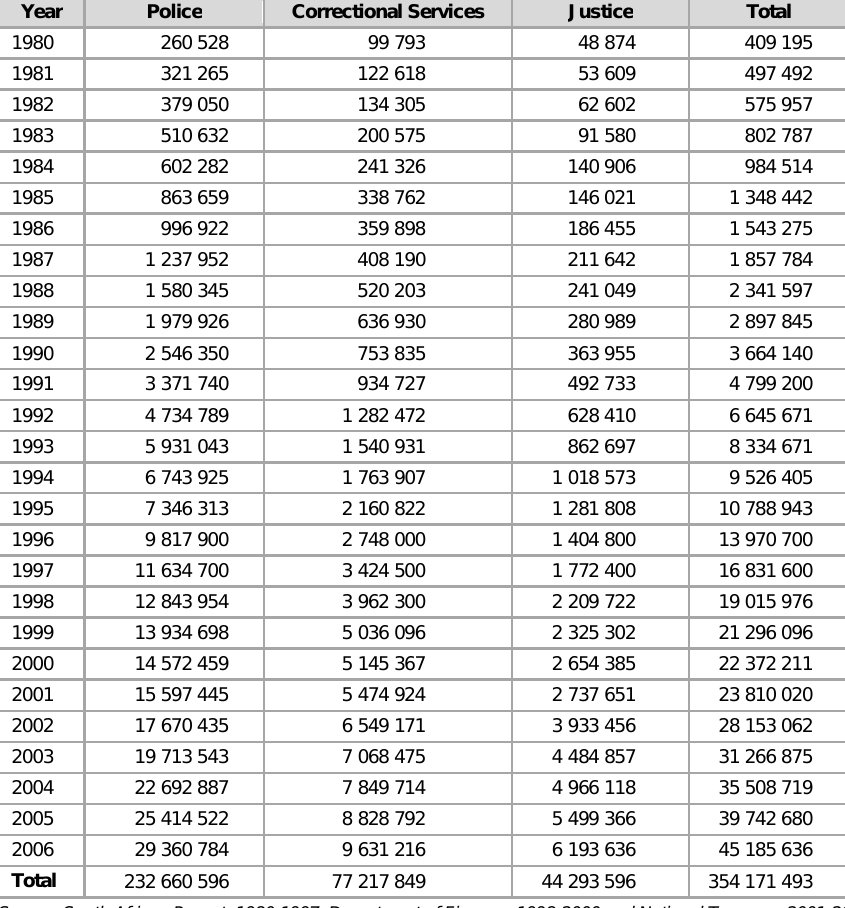
Government expenditure on the criminal justice system: 1980-2006